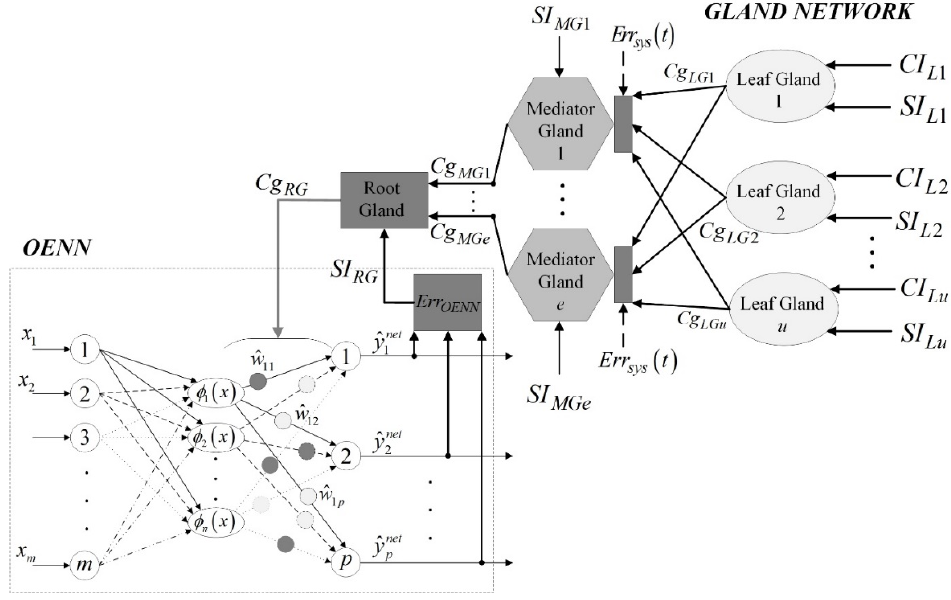
Figure 2. Integration of a gland network within OENN structure.